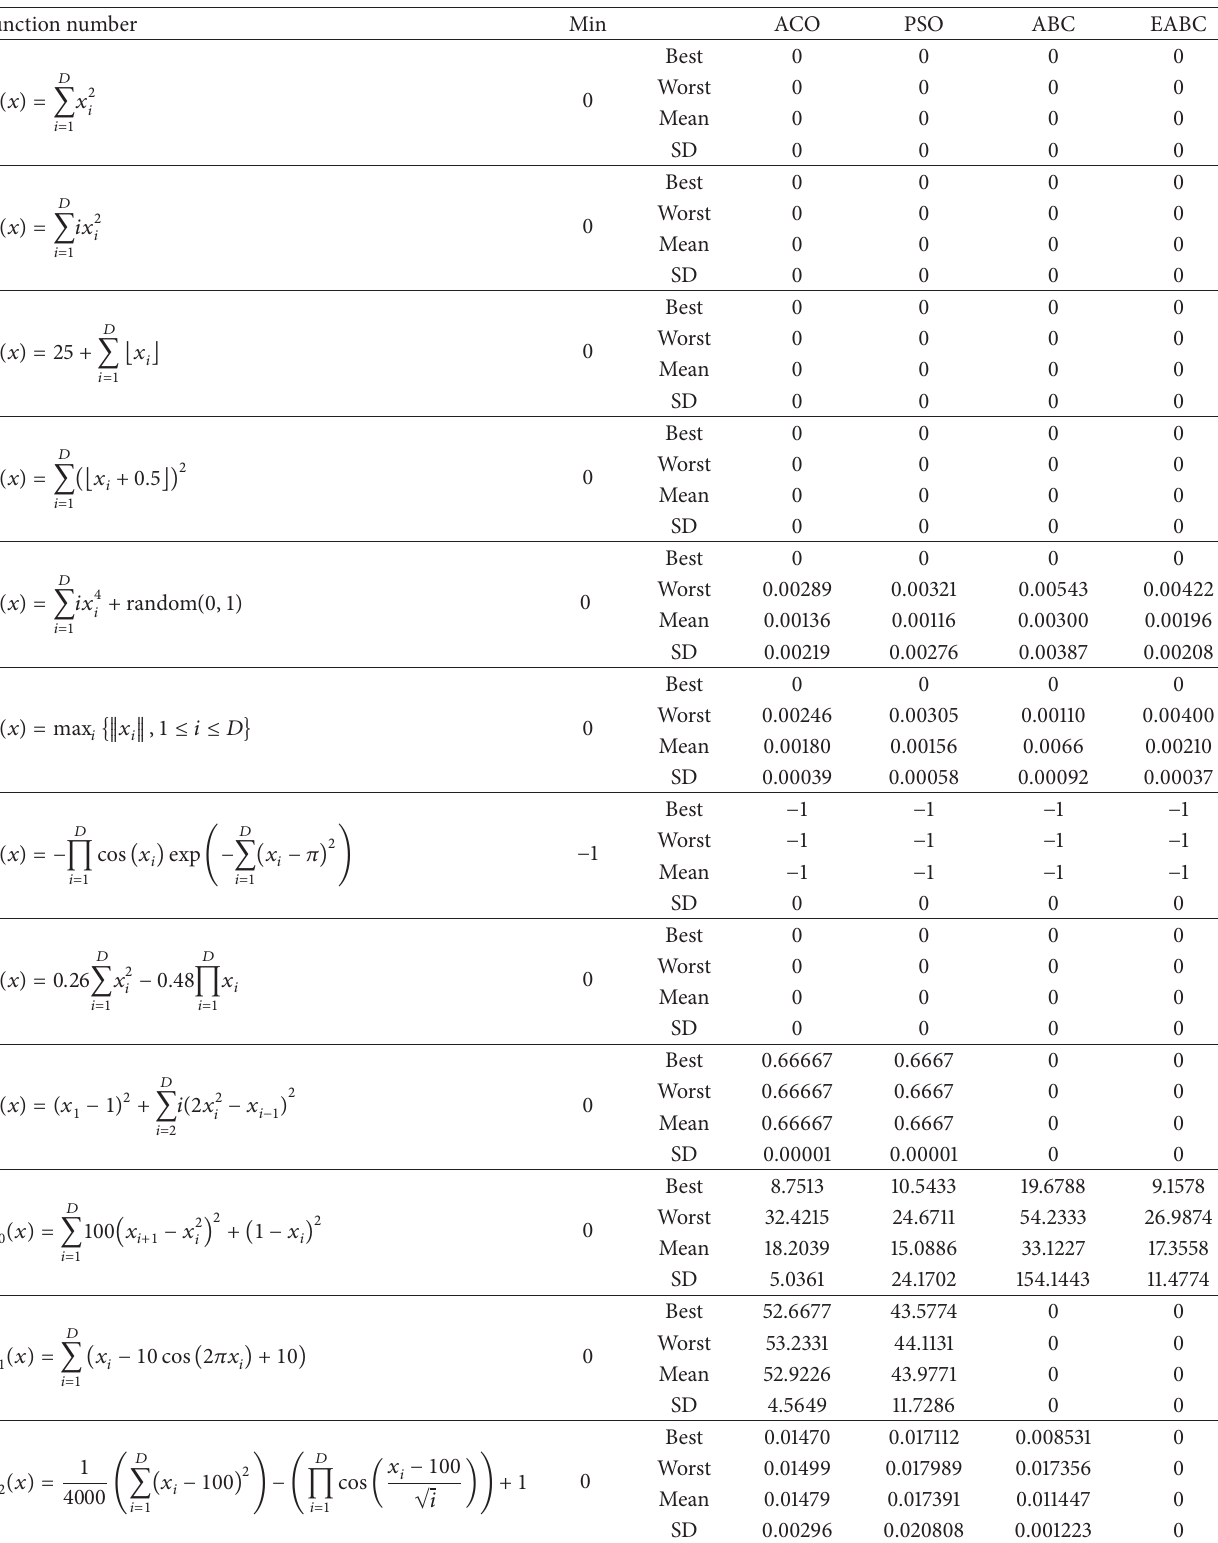
Table 2: Benchmark functions used in experiments for testing the performances of EABC, ACO, PSO, and ABC. Function number